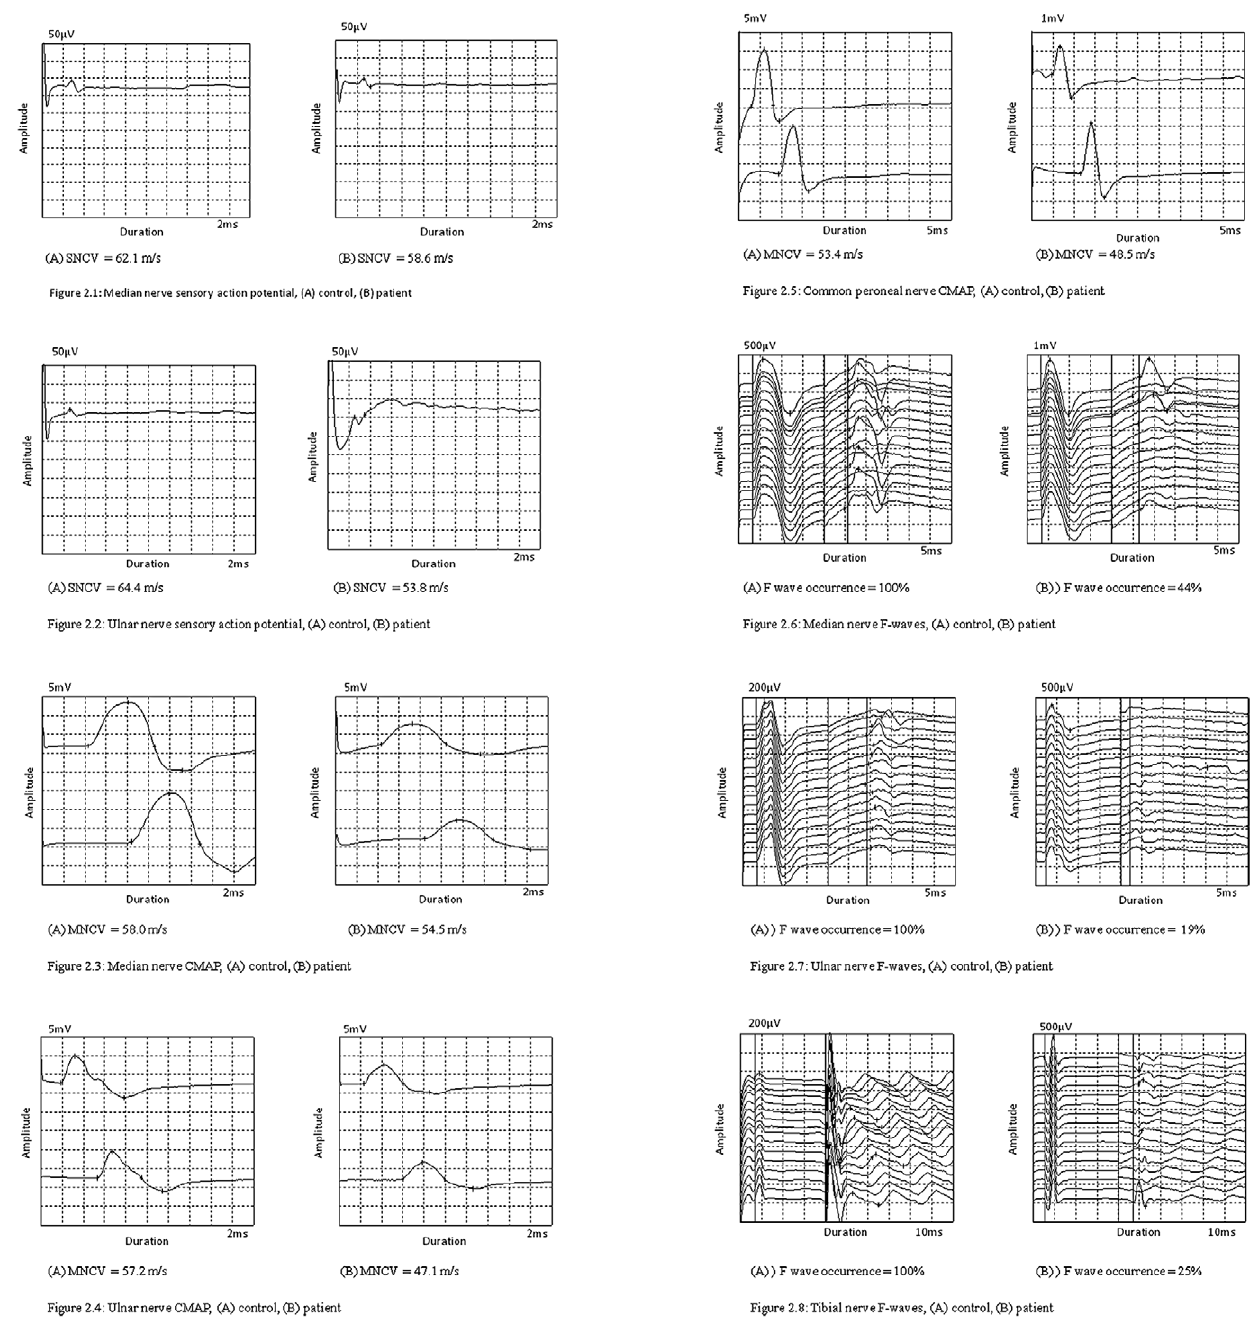
Figure 2. Wave forms of nerve conduction studies. Figure 2.1 - Median nerve sensory action potential, (A) control, (B) patient. Figure 2.2 - Ulnar nerve sensory action potential, (A) control, (B) patient. Figure 2.3 - Median nerve CMAP, (A) control, (B) patient. Figure 2.4 - Ulnar nerve CMAP, (A) control, (B) patient. Figure 2.5 - Common peroneal nerve CMAP, (A) control, (B) patient. Figure 2.6 - Median nerve F-waves, (A) control, (B) patient. Figure 2.7 - Ulnar nerve F-waves, (A) control, (B) patient. Figure 2.8 - Tibial nerve F-waves, (A) control, (B)